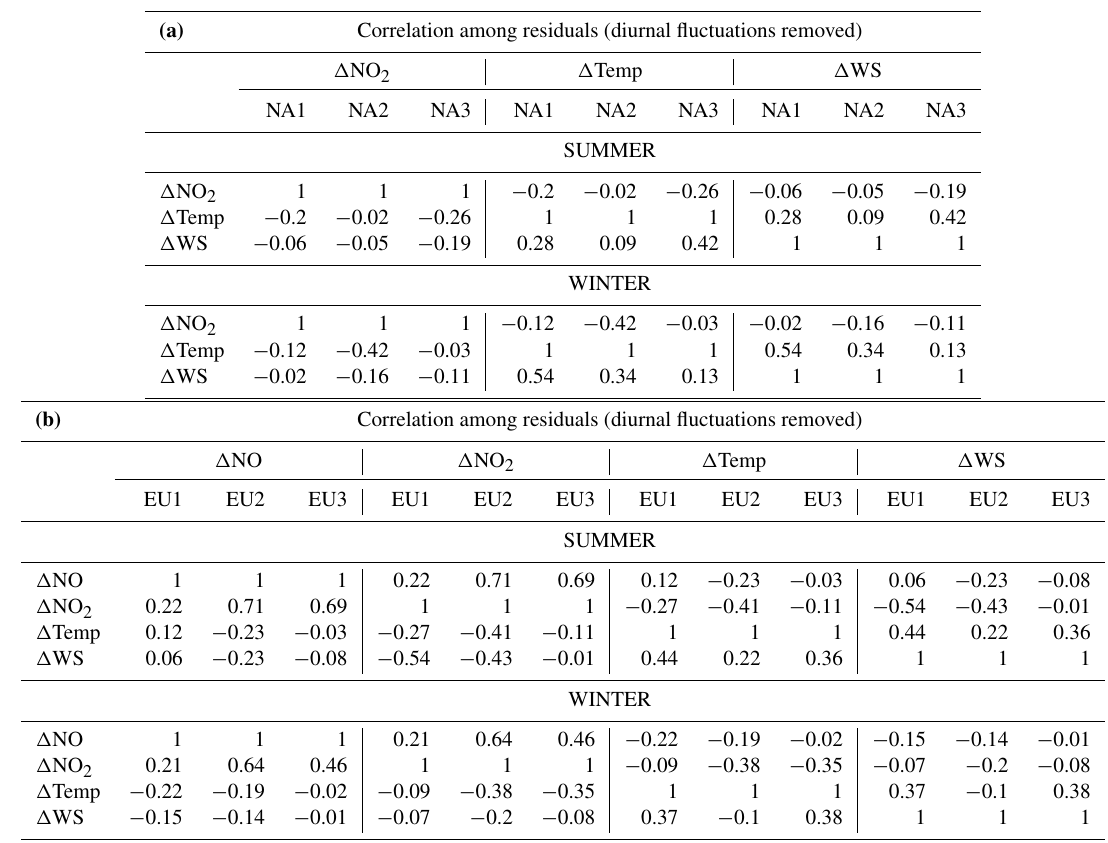
Table 3. Linear correlation coefficient between the residuals of the regressors of Eq. (3), when the diurnal fluctuations are filtered out. The residuals are calculated by removing fluctuations faster the ∼ 1.5 days. All the correlation values are significant up to 1% significance threshold from the measured and modelled time series. (a) NA; (b) EU. For each set of variables, the regression analysis includes the rural stations within a maximum differential altitude of